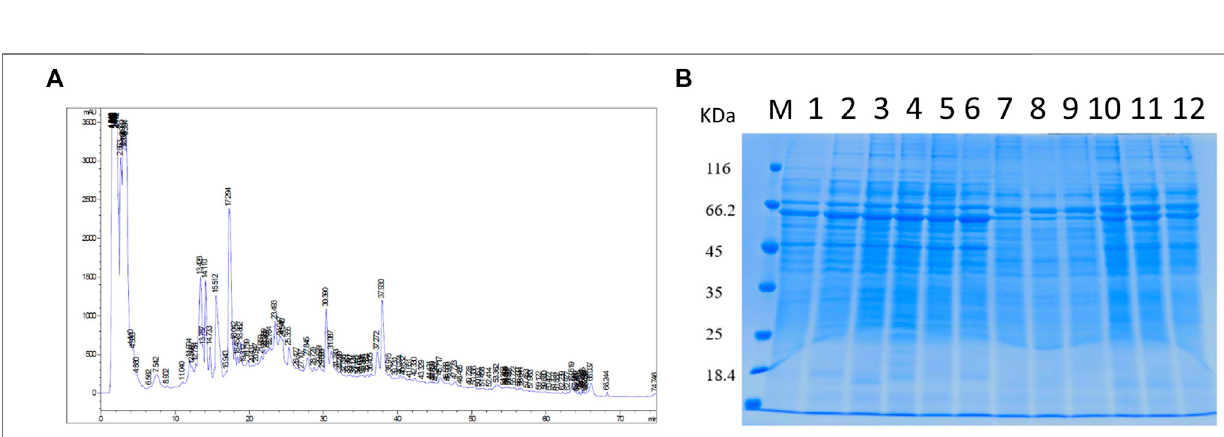
Frontiers in Genetics |